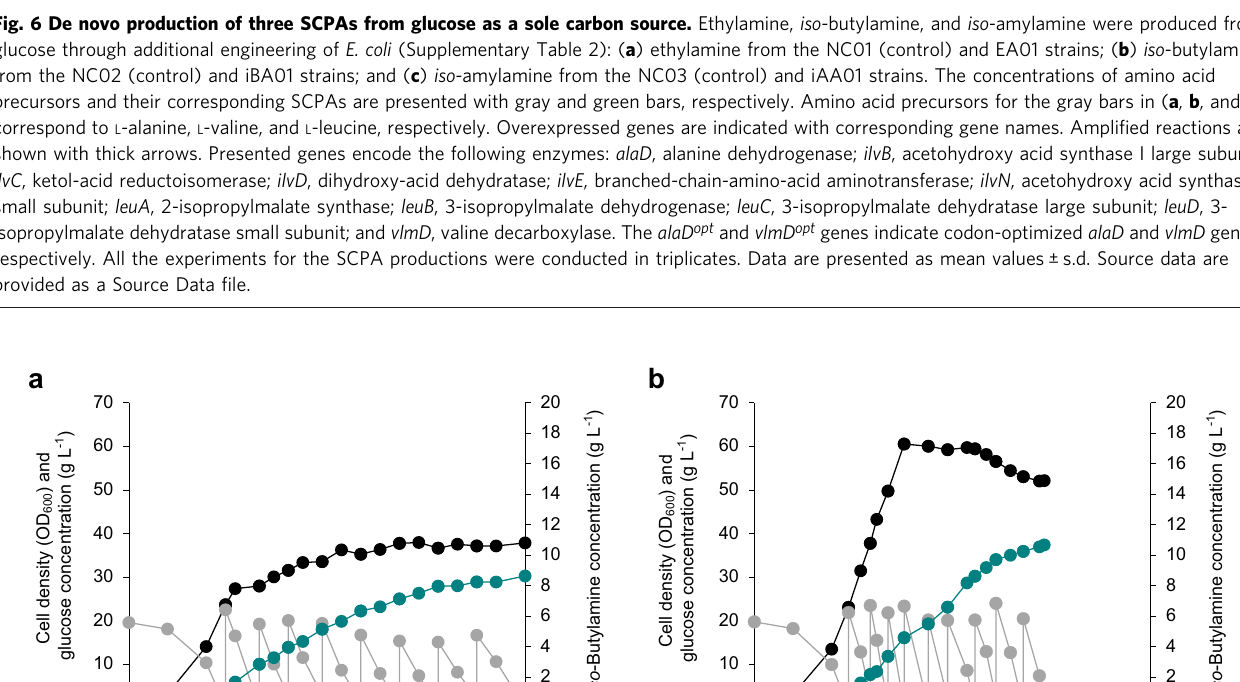
Fig. 7 Fed-batch fermentations for the enhanced production of iso -butylamine. a Fermentation pro fi le of the iBA01 strain, which was cultured in the NM3 medium that includes L -isoleucine, L -leucine, and D -pantothenate. b Fermentation pro fi le of the iBA02 strain, which was cultured in the same NM3 medium as the iBA01 strain, but without L -isoleucine, L -leucine, and D -pantothenate. Another fed-batch fermentation pro fi le of the iBA02 strain, which was conducted for the reproducibility, is available in Supplementary Fig. 5. Cell density (OD 600 ), glucose concentration, and iso -butylamine concentration are presented with black, gray, and green circles, respectively. Source data are provided as a Source Data fi